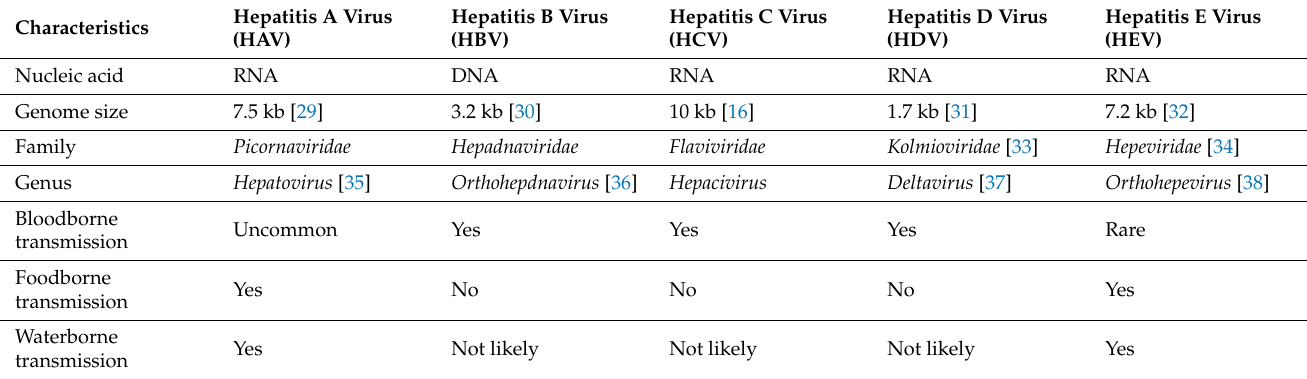
Table 1. Properties of hepatotropic viruses and their transmission